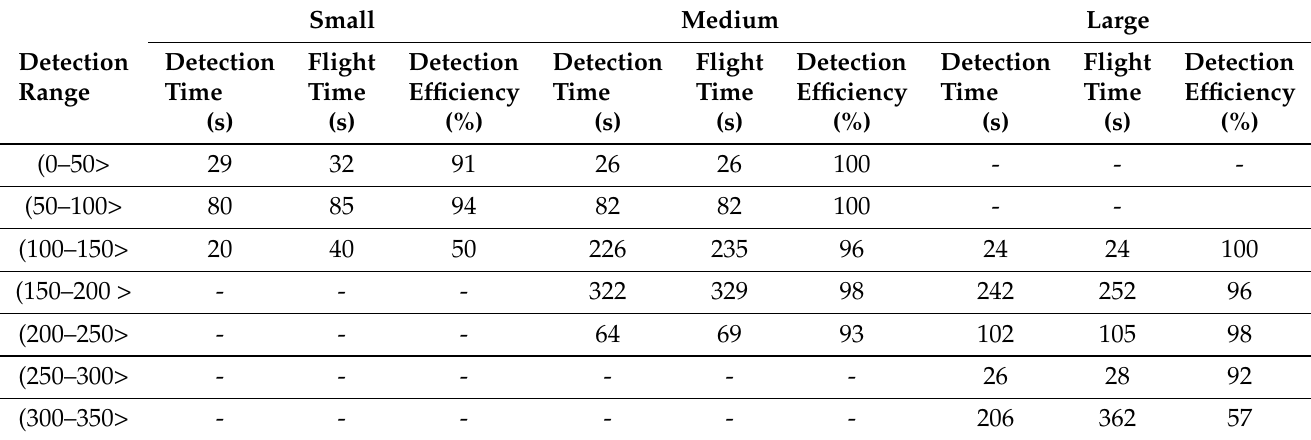
Table 4. Evaluation of system detection